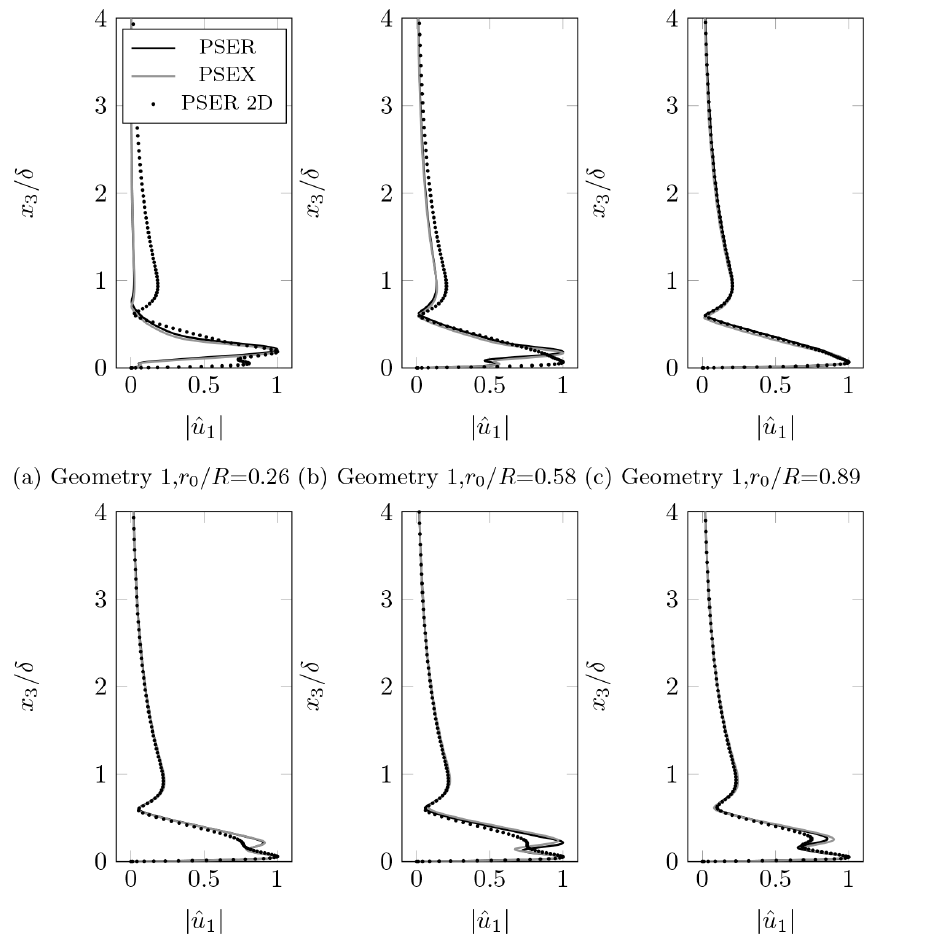
Figure 13. PSE results for the mode leading to transition.